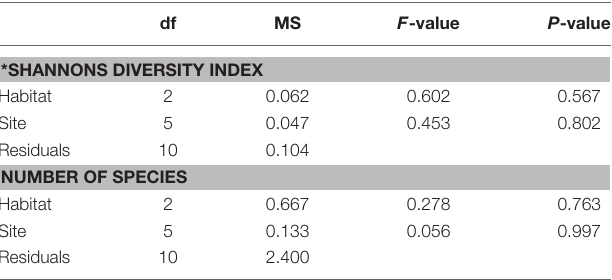
TABLE 2 | Randomized block analysis of variance of log-transformed number of species per habitat and Shannon-Wiener diversity index.